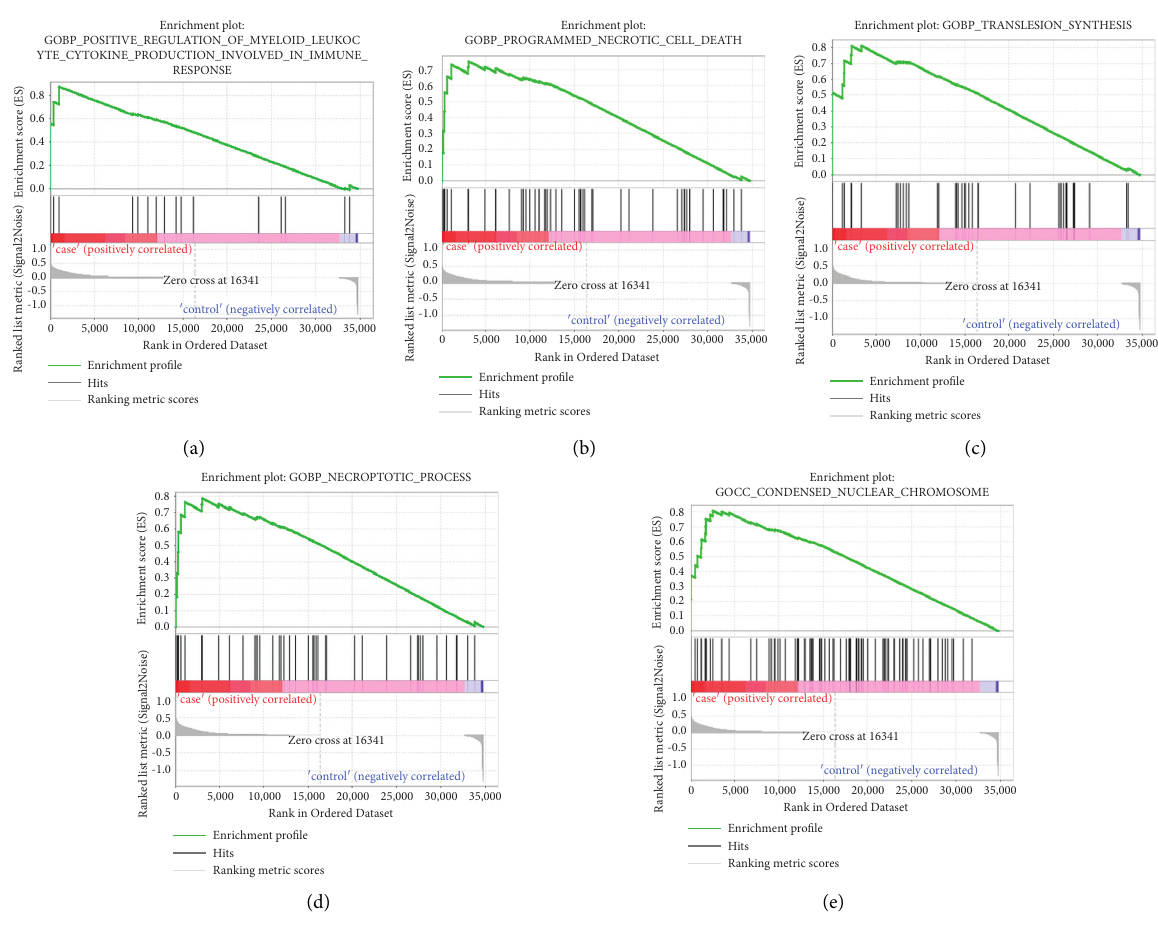
Figure 4: GSEA showed GO terms related to COVID-19-caused death lung tissue samples. (a) Positive regulation of myeloid leukocyte cytokine production in the immune response. (b) Programmed necrotic cell death. (c) Translesion synthesis. (d) Nec- roptotic process. (e) Condensed nuclear